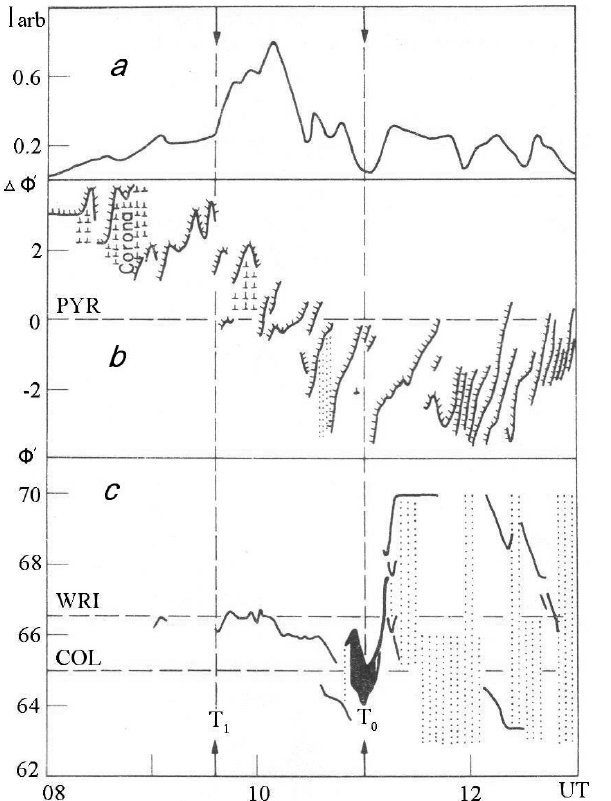
Figure 22. Dynamics of the daytime (station Pyramida, PYR) and nighttime (stations Wrangel Island, WRI, and College, COL) au- rorae on 18 December 1957: (a) the daytime auroras’ brightness in arbitrary units; (b) and (c) the auroras’ development versus UT over daytime and nighttime stations, respectively. Horizontal dashed lines are the zenith of the observatories. The positions of homogeneous arcs are shown by solid lines; that of rayed ones by herringbone, and the diffuse luminosity by dots (Vorobjev et al.,